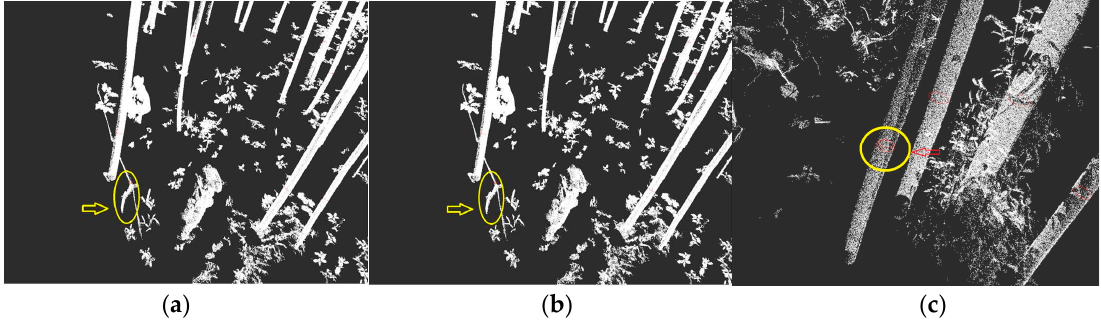
Figure 5. Three types of detection error. ( a ) The mark shows an existing broad-leaved tree or bamboo but not recognized during the extraction of point-cloud data. ( b ) The mark shows a ‘false positive’: the scan marked it as a broad-leaved tree or bamboo in the point-cloud data although no such tree or bamboo was present at the location. ( c ) The mark shows the trunk of a single tree whereas there were two separate trees at the spot.